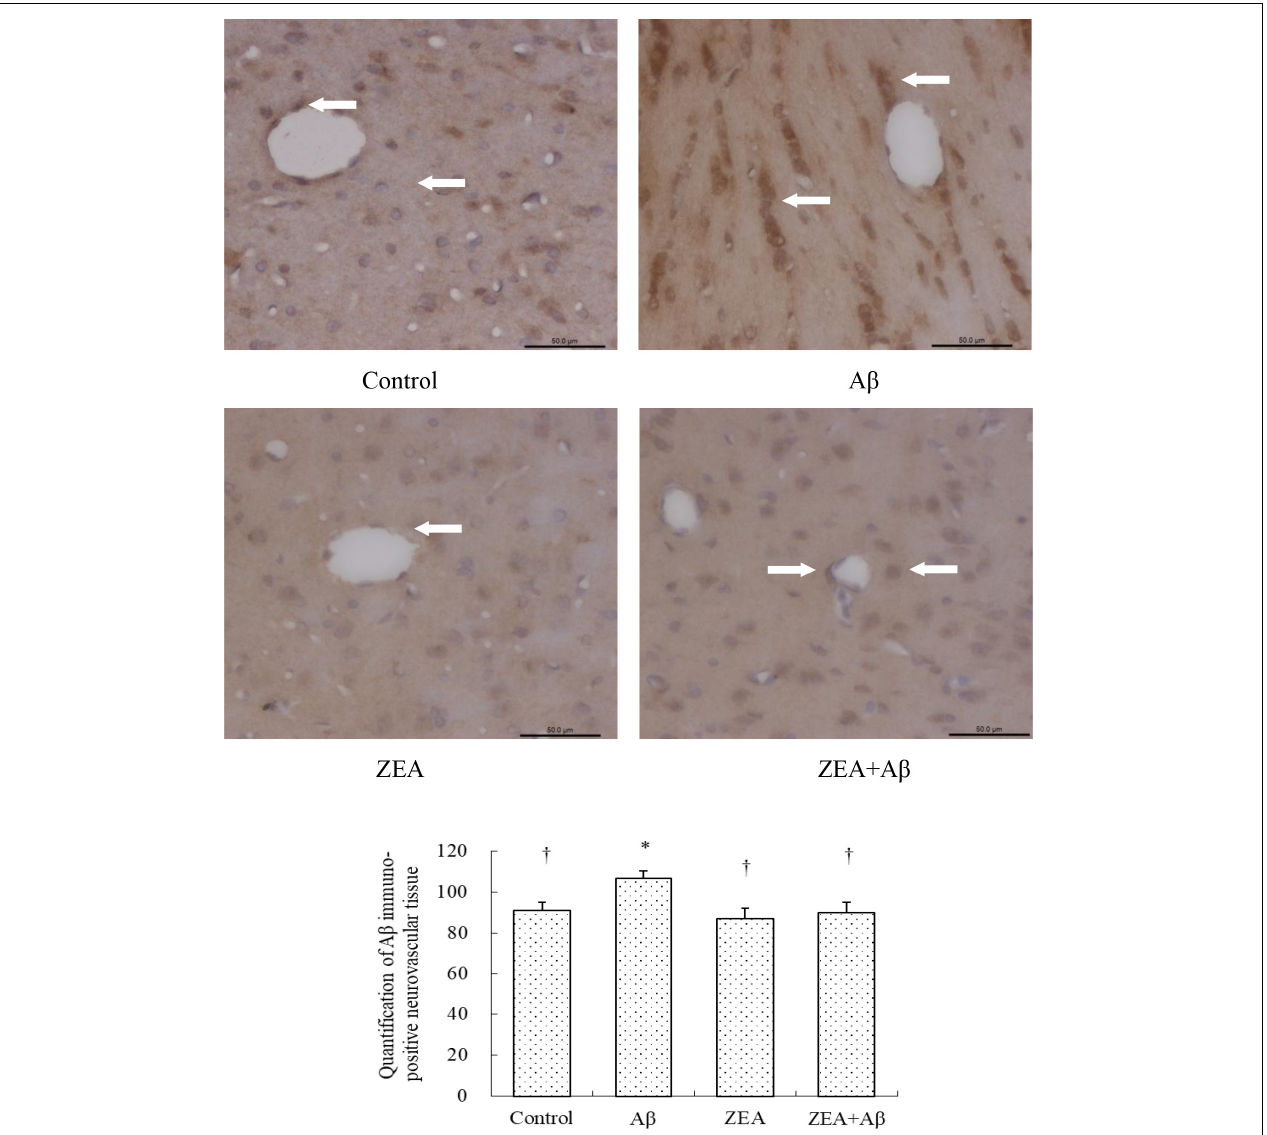
FIGURE 6 | Neuroprotective effects of ZEA on A β in the cerebrovascular tissue of learning and memory impairment rats induced by A β 1–42. Immunohistochemistry was used in the paraffin section of the whole rat brain from four treatment groups mentioned before ( n = 12 per group). All the data were shown as mean ± SD, and analyzed by the one-way ANOVA test [ post hoc (LSD) test]. ∗ Significantly different from the Control group ( p < 0.05). † Significantly different from the A β group ( p < 0.05). Staff gauge showed 100 µ m at the right side of every pictures’